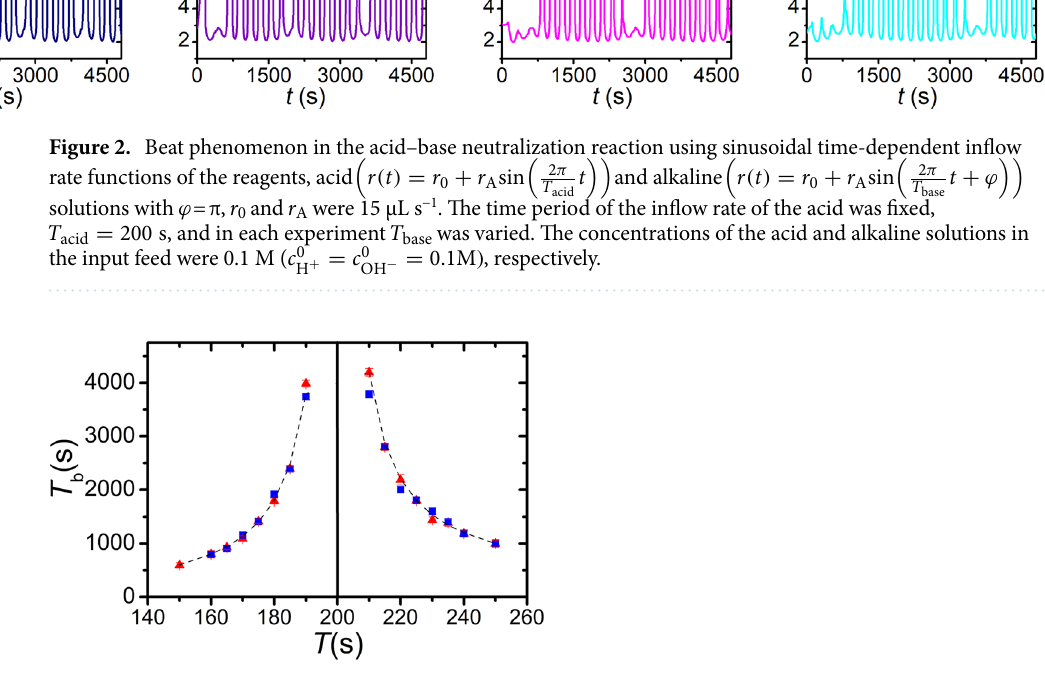
Figure 3. Dependence of the time period of the chemical beat phenomenon ( T b ) on the time period of one inflow rate (the time period of other inflow rate was fixed to 200 s) observed in the experiments in the acid–base neutralization reaction using sinusoidal time-dependent inflow rate functions of the reagents, acid 2 π 2 π r ( t ) = r 0 + r A sin r ( t ) = r 0 + r A sin t t + ϕ and alkaline solutions with ϕ = π, r 0 and r A were T acid T base (cid:31) (cid:31) (cid:31) (cid:31) (cid:30)(cid:30) (cid:30)(cid:30) 15 µL s −1 . Blue and red symbols present the data when the time period of acid and base inflow rates was fixed ( T = 200 s) once the time period of base and acid inflow rates was changed in the experiments, respectively. The 0 = 0.1M ) , = c 0 concentrations of the acid and alkaline solutions in the input feed were 0.1 M ( c OH − H + respectively. The dashed lines represent the theoretically calculated curves from the relation T b